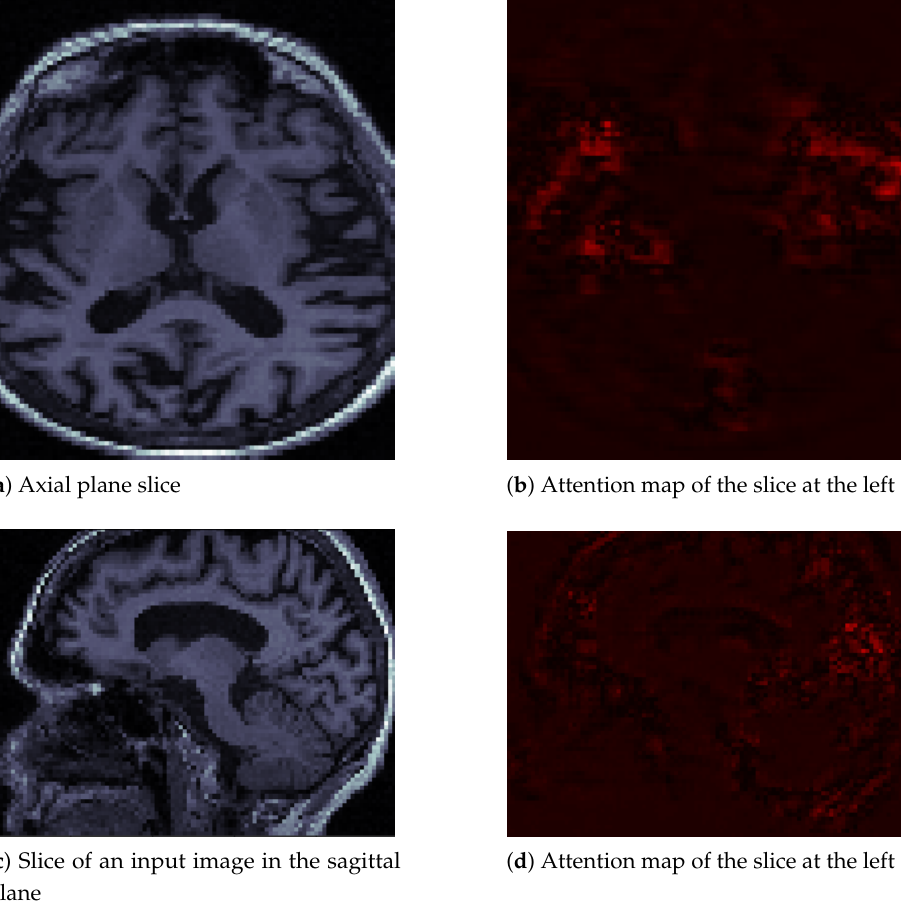
Figure 6. Input image slices and their attention maps from an MRI of a patient with